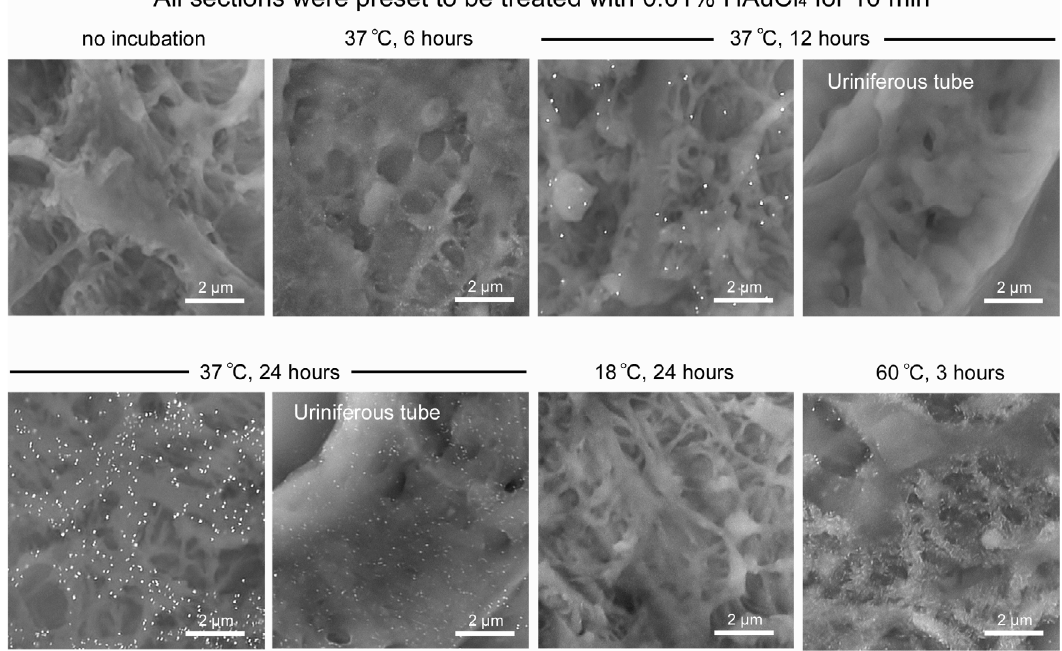
Fig. 3 Coordination of the duration and temperature of hot-humid incubation. All sections were preset to be treated with 0.01% HAuCl 4 for 10 min. Note the immature growth of nanogold particles after hot-humid incubation at 37 °C for 6 h. Satisfactory labeling was observed after 12 h, but elongation to 24 h caused nonspeci fi c particles on the uriniferous tube. No labeling was developed in the humid chamber at 18 °C for 24 h. Incubation at 60 °C accelerated nanogold development, but the underlying structure of the podocyte process was signi fi cantly